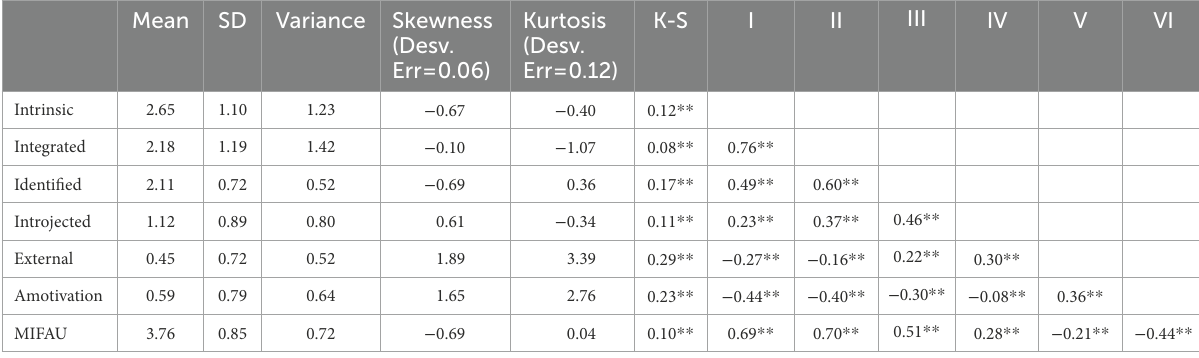
TABLE 1 Descriptive results of the variables associated with the BREQ-3 and the